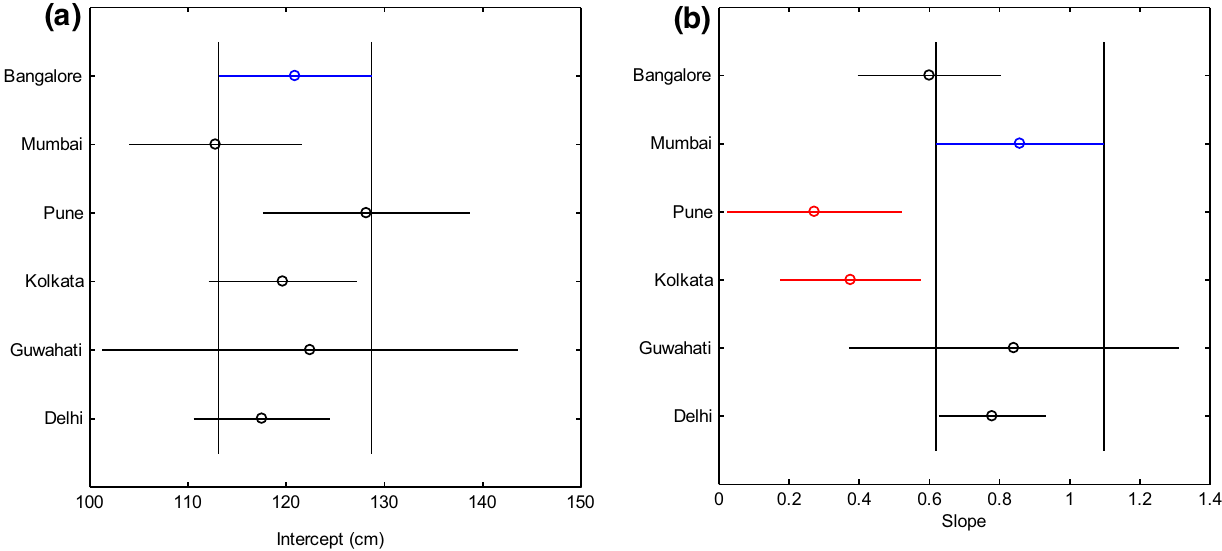
Fig. 6 Comparison of range of estimated slopes and intercepts of LC versus average speed relationships between interacting vehicle pairs moving in different cities. a Test for variation of intercepts for different cities. b Test for variation of slopes for different